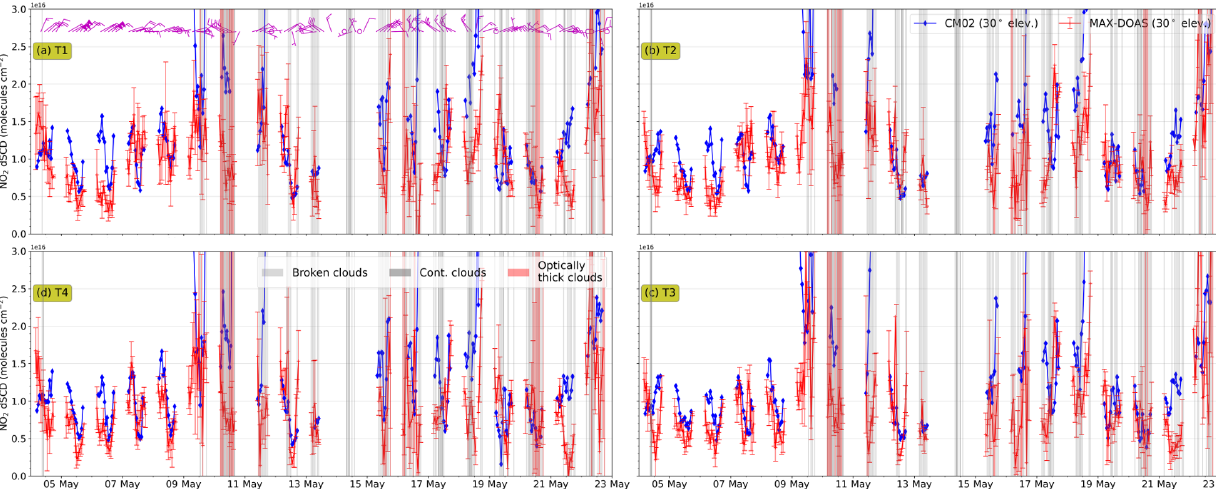
Figure 9. Comparison of NO 2 differential slant column densities at 30 ◦ elevation angle of the four telescopes simulated using UBA di in the CM02 domain. The shaded regions in the time series represent various categories of sky conditions as described in the legend.